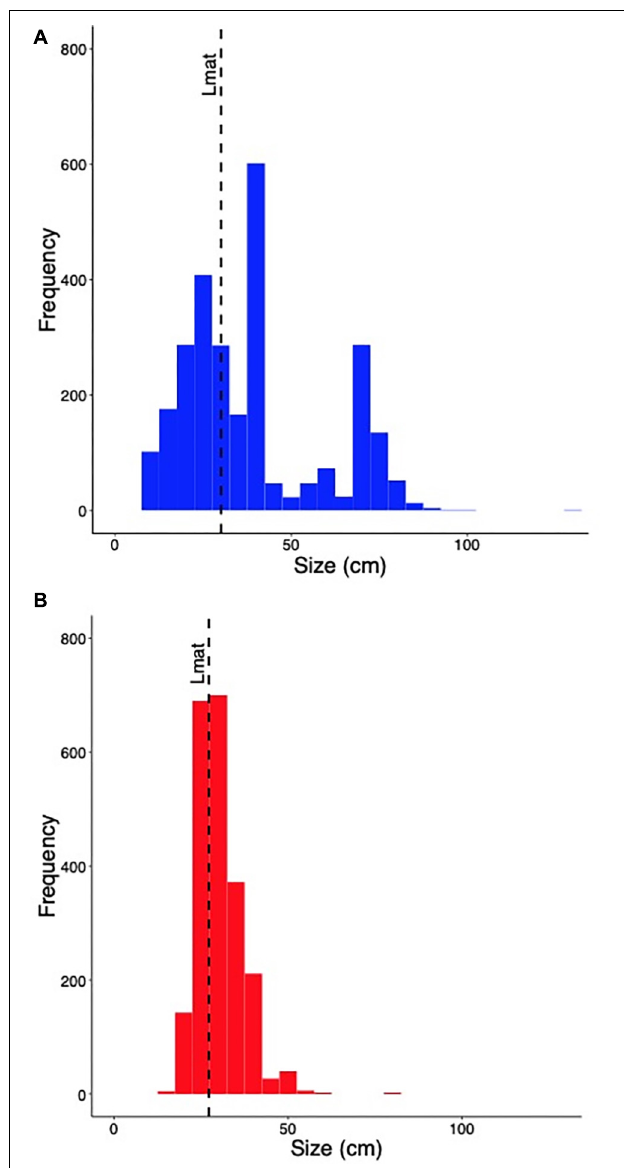
FIGURE 4 | Size-frequency distribution of fish captured using (A) handline, and (B) speargun. The dashed line represents the biomass-weighted mean length (cm) at first maturity of the catch (L mat ).